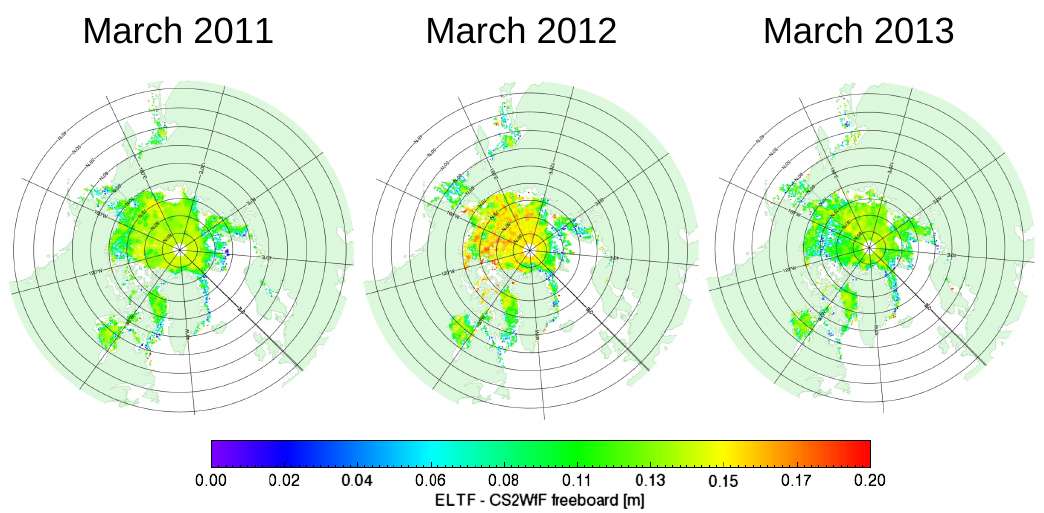
Figure 12. Freeboard difference between the CS2WfF method and the ELTF method.